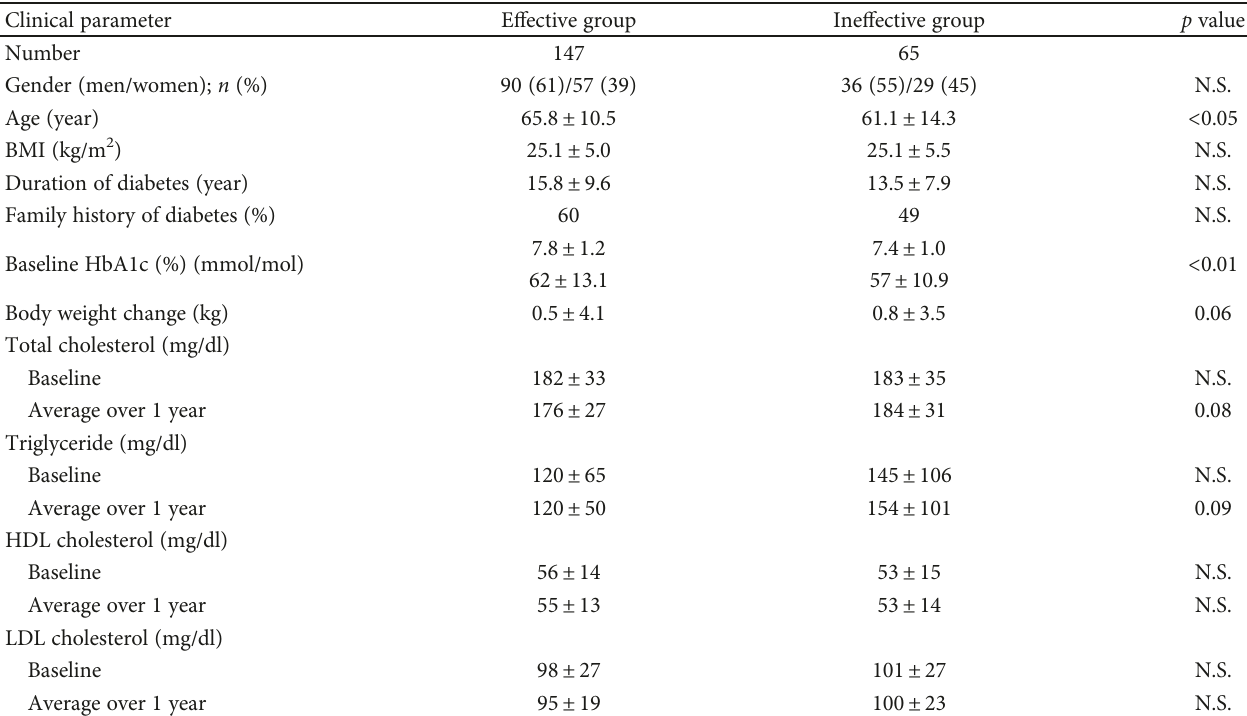
Table 1: Comparison of clinical background between the e ff ective group and ine ff ective group in all participants with type 2 diabetes.